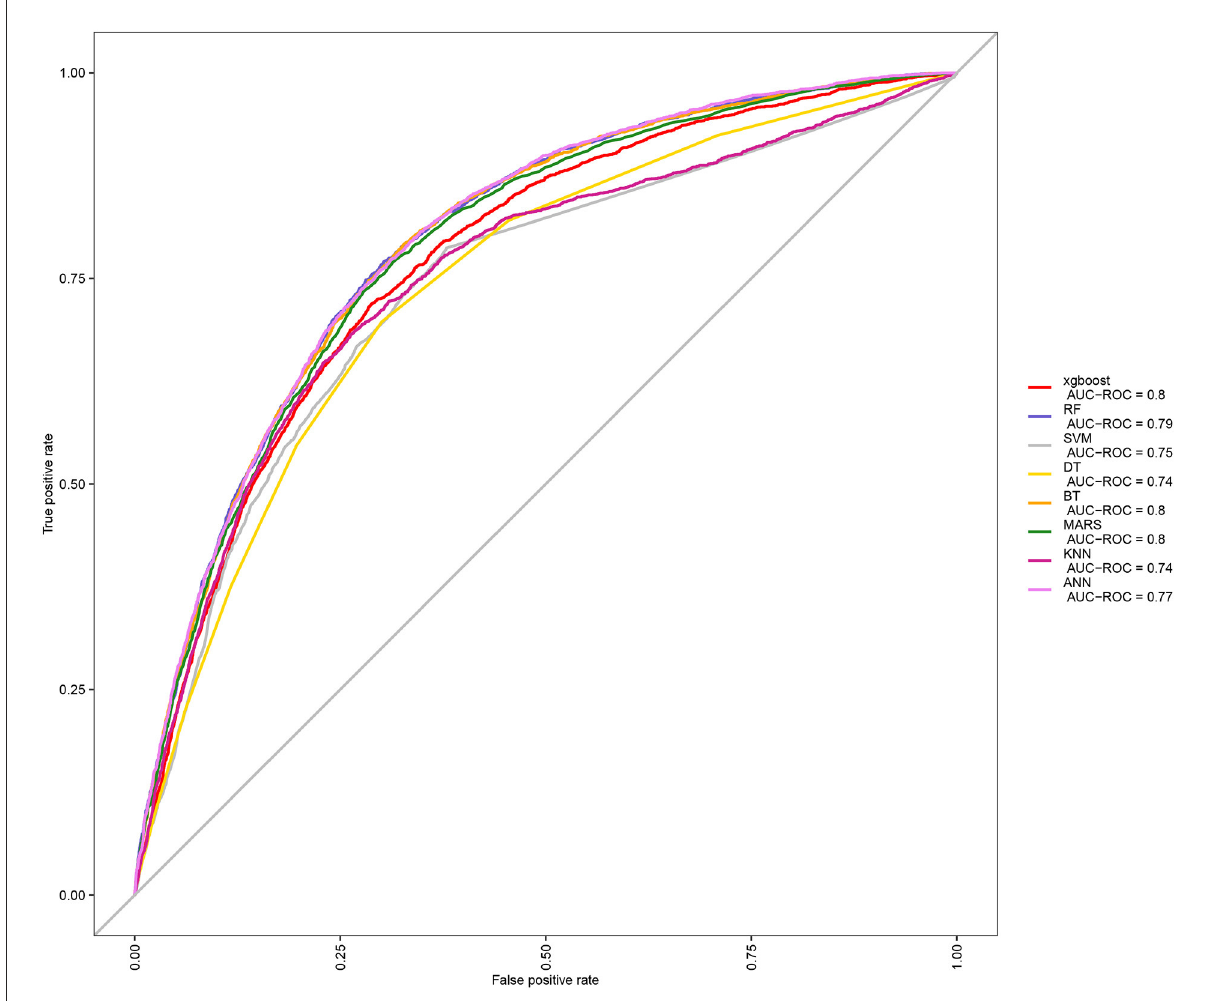
FIGURE2 Comparison among eight machine learning algorithms in ROC